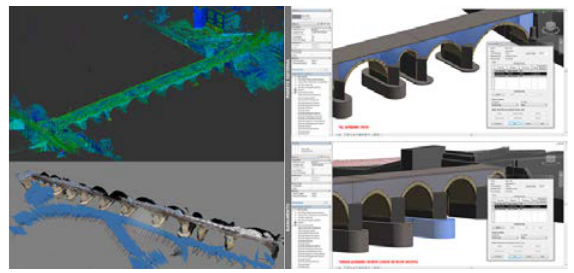
Figure 9. Images and laser scans acquired for the generation of the generation of a BIM at the scale